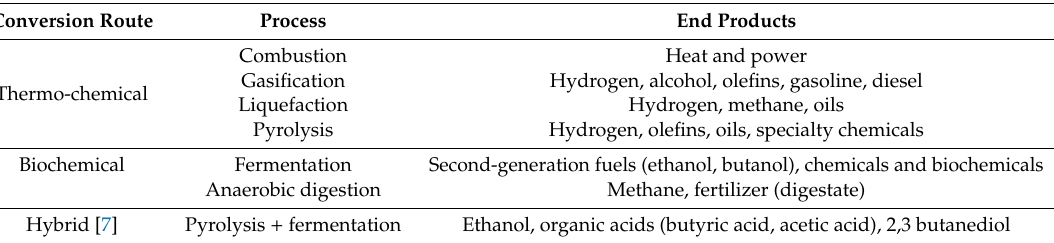
Table 2. Conversion routes, processes, and end products using lignocellulosic biomass as